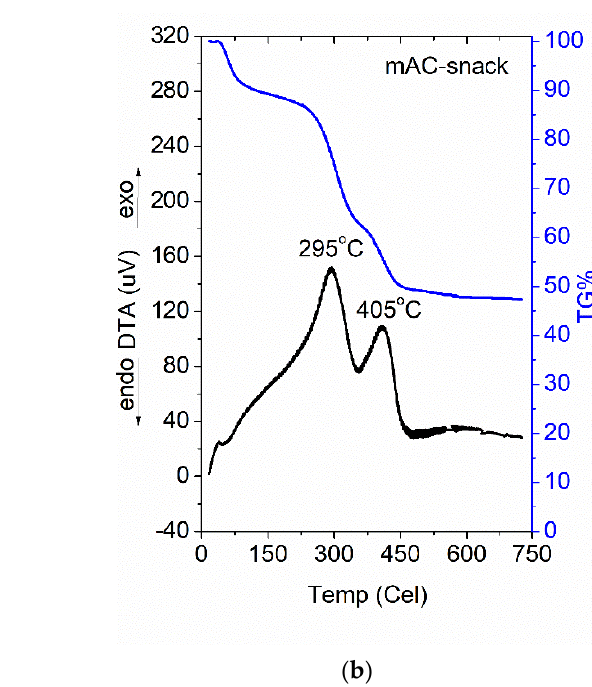
Figure 5. DTA and TGA curves of AC-snack ( a ) and mAC-snack ( b ) samples.